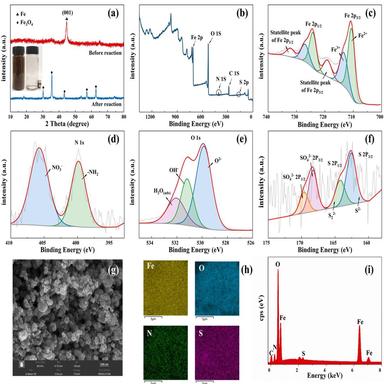
XRD spectra of anode materials and precipitate (a); total XPS spectra of precipitate (b), Fe2p spectra (c), N1S spectra (d), O1S spectra (e), S2p spectra (f) and SEM-EDS spectra of precipitate (g-i).